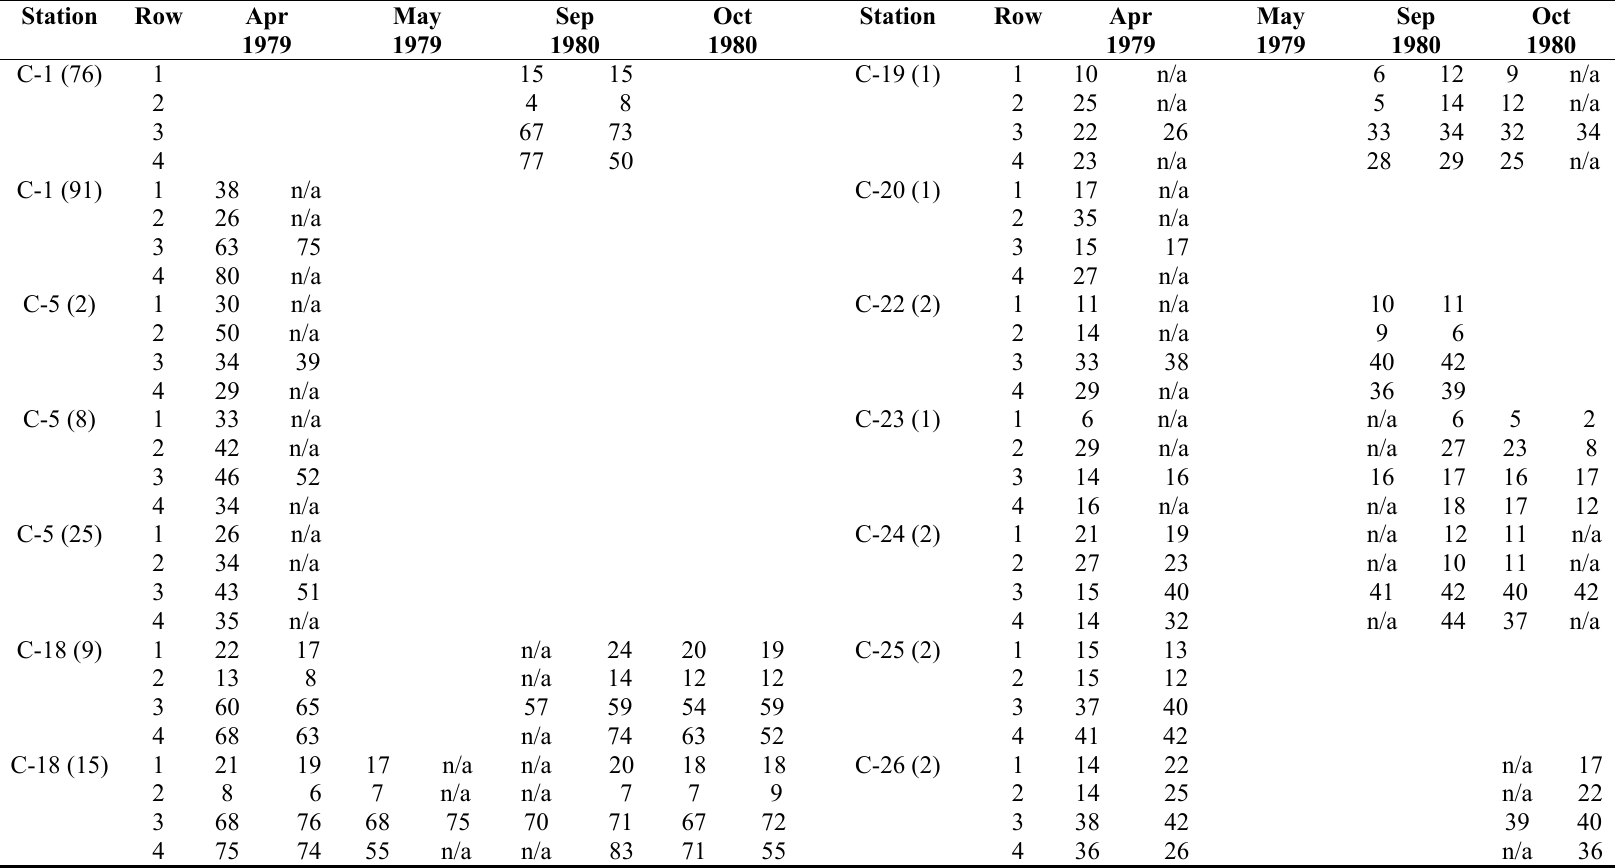
Table 10. Current Speed Hindcast Validation: April 1979–October 1980. In each box, the first column of values corresponds to the first 15 days of the month, with the second column of values denoting the remaining portion. For each column: Row 1 corresponds to the RMSE in cm/s. Row 2 corresponds to the Willmott Relative Error in percent. Row 3 corresponds to the model mean in cm/s with Row 4 denoting the observed mean current speed in cm/s. Note n/a denotes not available due to incomplete observations. Along with the station id, the measurement location (in distance above the bottom in meters) is given in